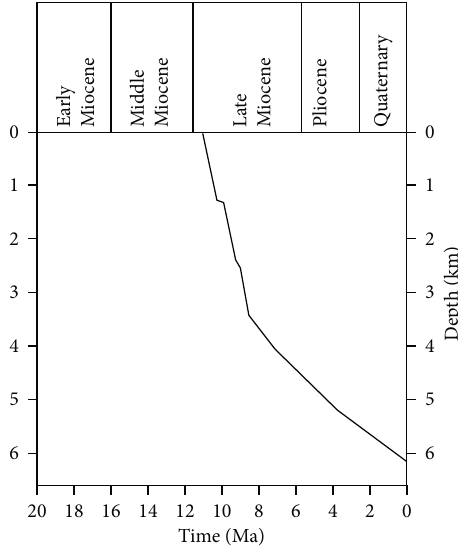
Figure 2: Subsidence curve of the Makó Trough by Balázs et al. (2017) [37] shows a very short and rapid synrift subsidence of the basement during early Late